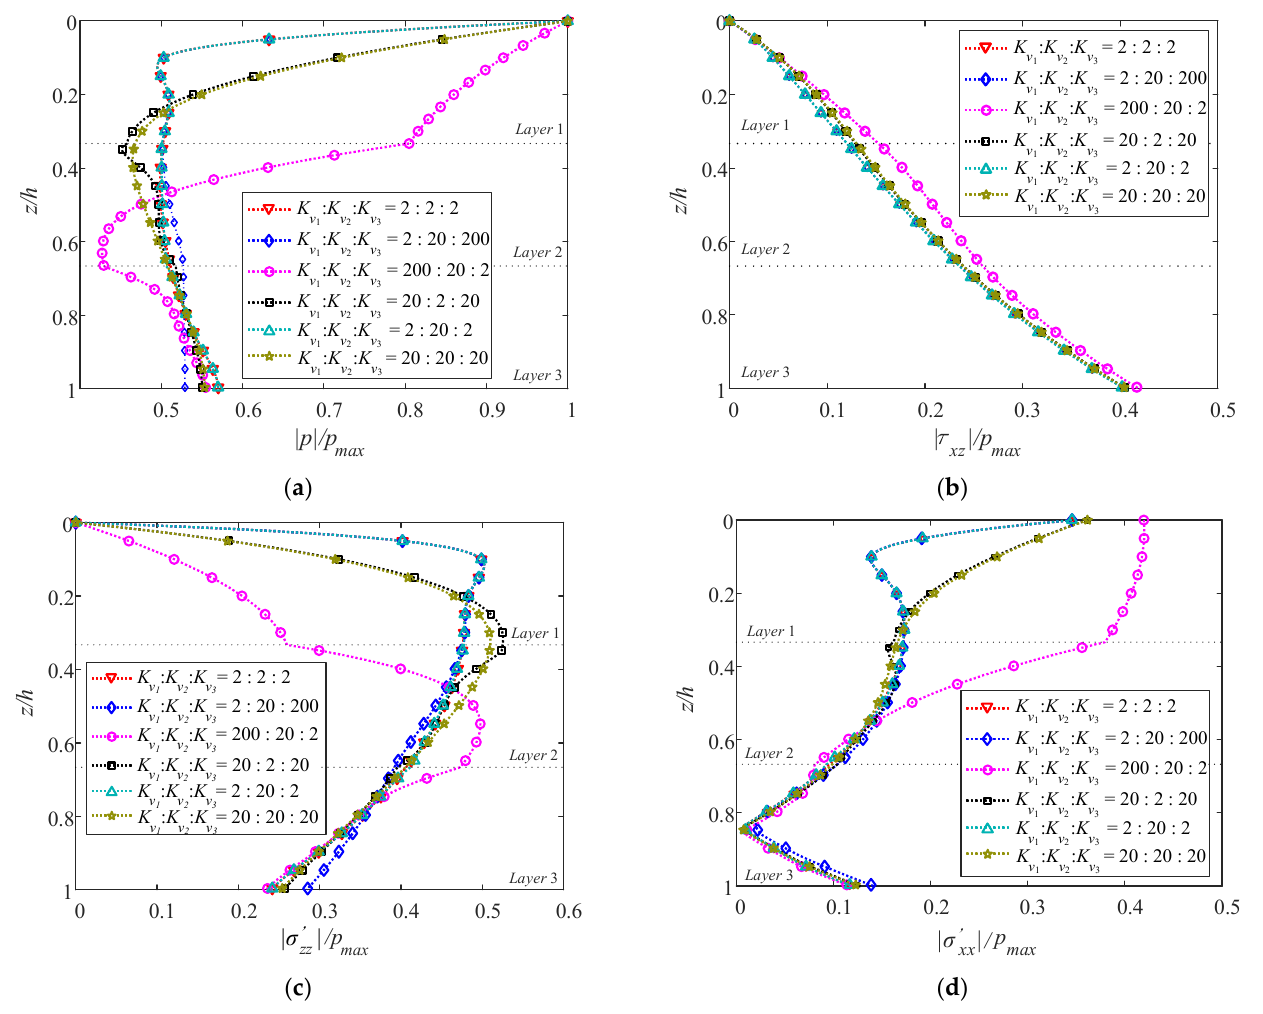
Figure 15. Vertical distributions of normalized maximum ( a ) pore pressure, ( b ) shear stress, ( c ) vertical effective stress, and ( d ) horizontal effective stress by varying K v 1 : K v 2 : K v 3 .